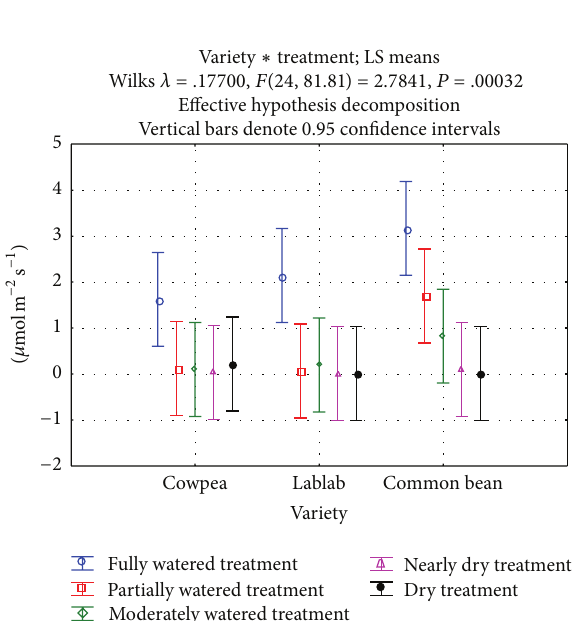
Figure 20: Stem-leaf ratio in different plants according to different watering